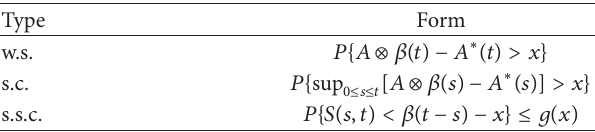
Figure 2: A network with multiple input